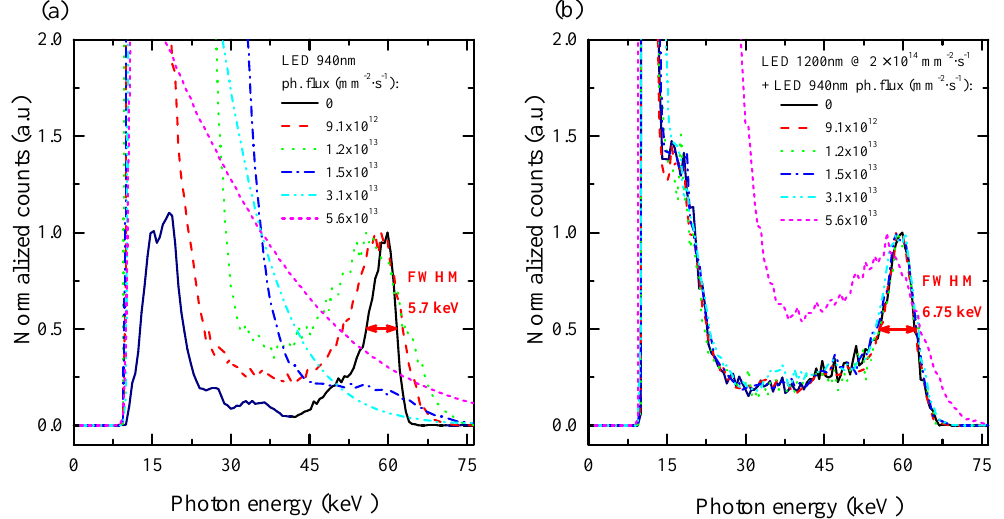
Figure 6. Pulse height spectra of γ - 241 Am obtained with Sample 2 under various levels of polarization by the LED at 940 nm ( a ) and with the additional depolarization ( b ), both at a 400-V bias. The spectra were normalized to the maximal number of counts for the photon energy equal to or higher than 35